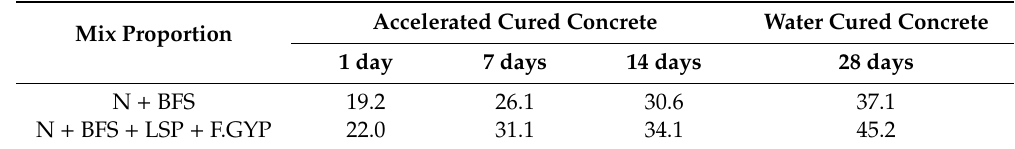
Table 6. Compressive strength of